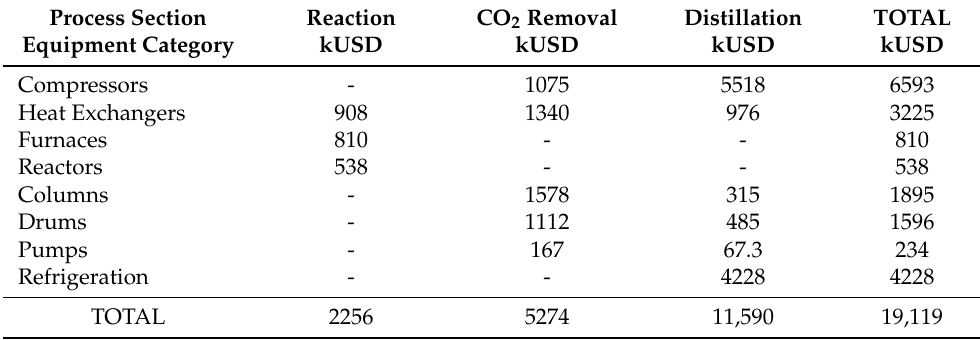
Table 5. Total cost of different equipment installed in each process